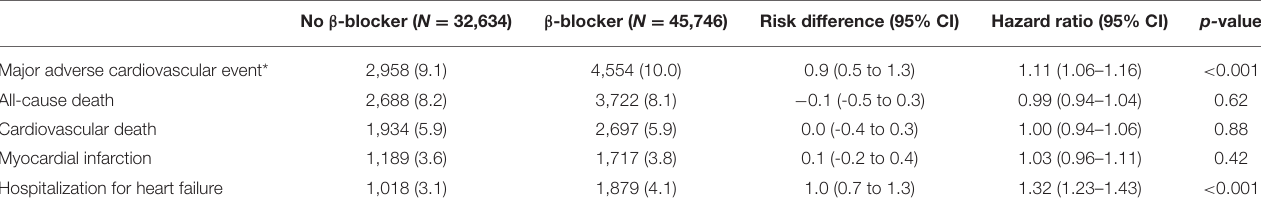
TABLE 2 | Risks of primary and secondary outcomes at 5 years after percutaneous coronary intervention between patients prescribed with or without β -blocker after stabilized inverse probability of treatment weighting.